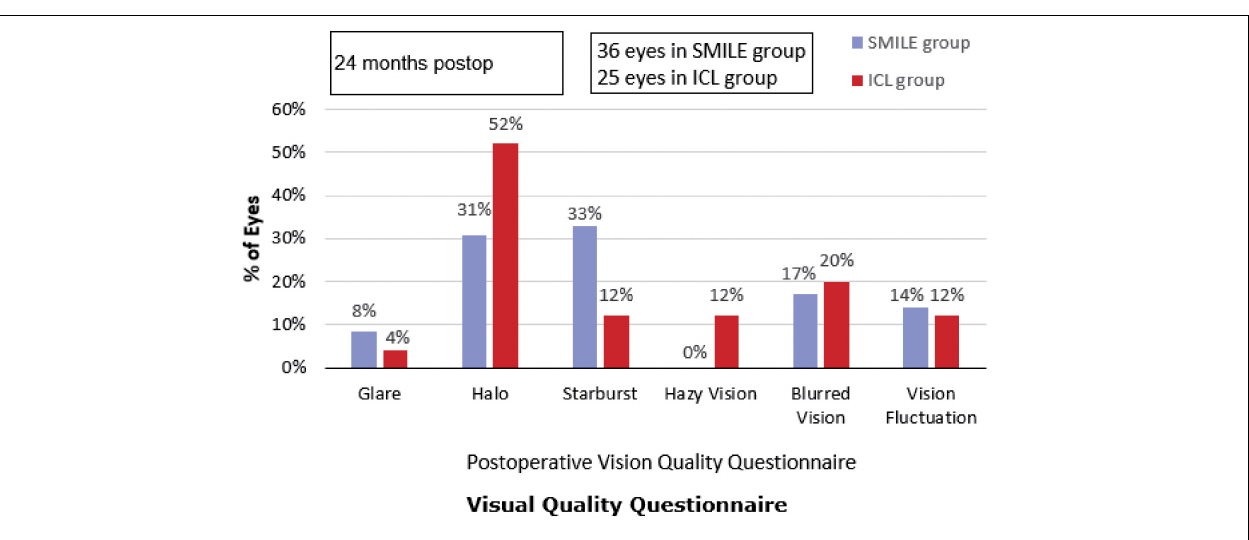
FIGURE 2 | Subjective visual quality after Implantable Collamer Lens (ICL) and small incision lenticule extraction (SMILE). postop: